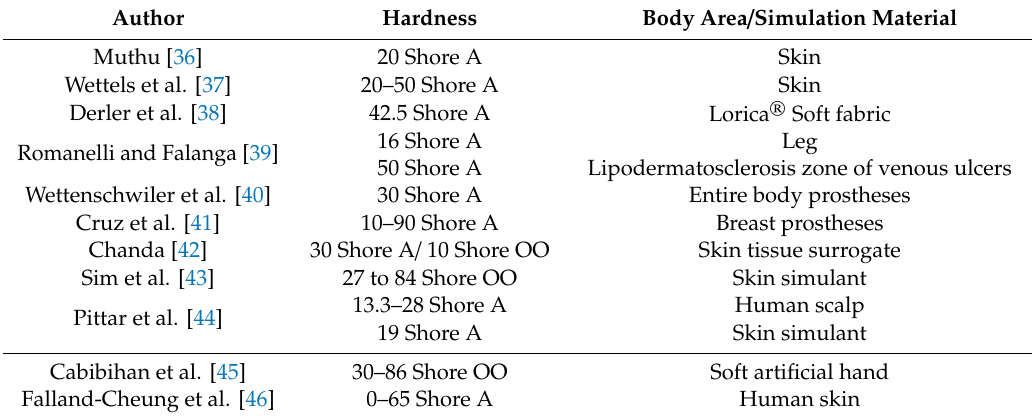
Table A1. Hardness of Human Body or Human Body